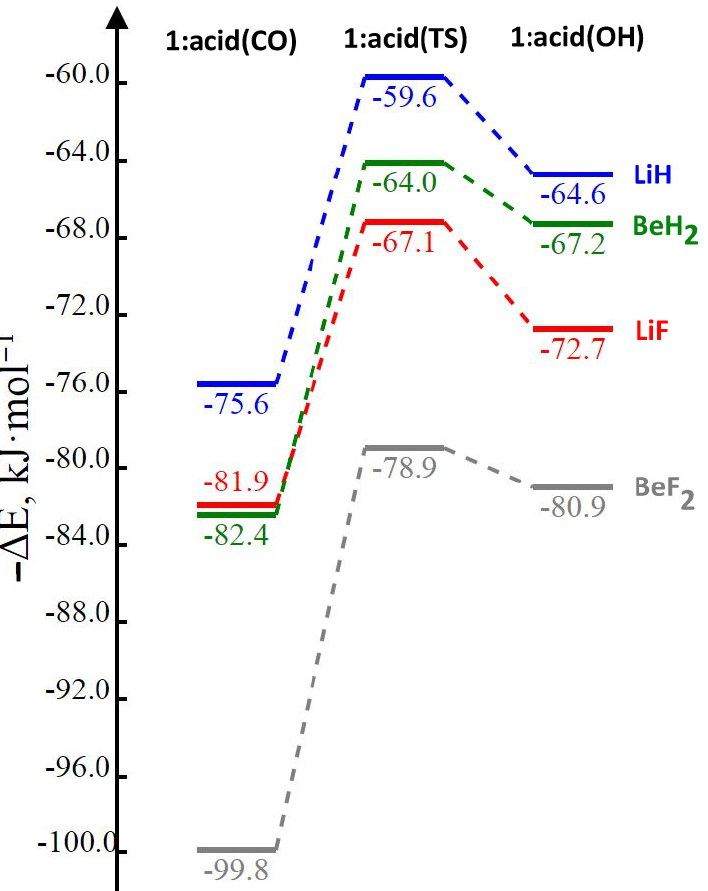
Figure 2. Binding energies of equilibrium and transition structures as a function of the nature of the complex. From these data, the barriers to interconverting the two equilibrium complexes can be readily obtained.